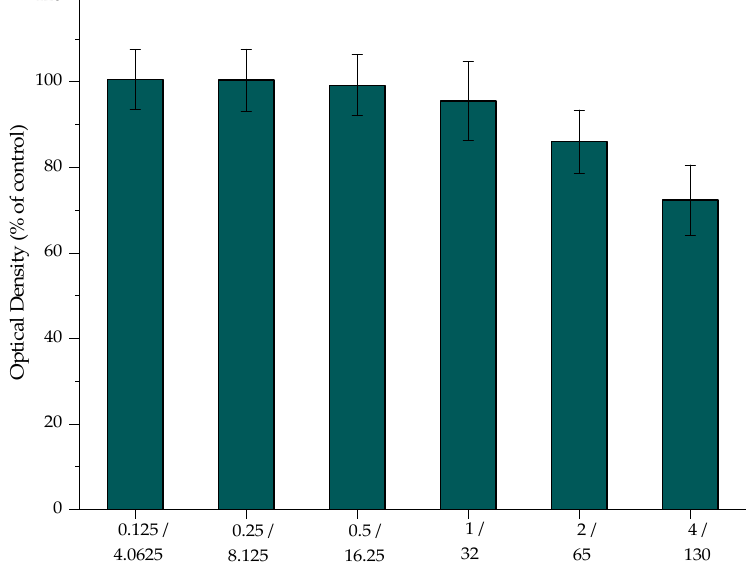
Figure 11. MTT assay of [ 177 Lu]Lu-MAPEG against the 4T1 cell line after 24 h. Mean values ( n = 3) and the SD (bars) are shown (x axis not in scale).